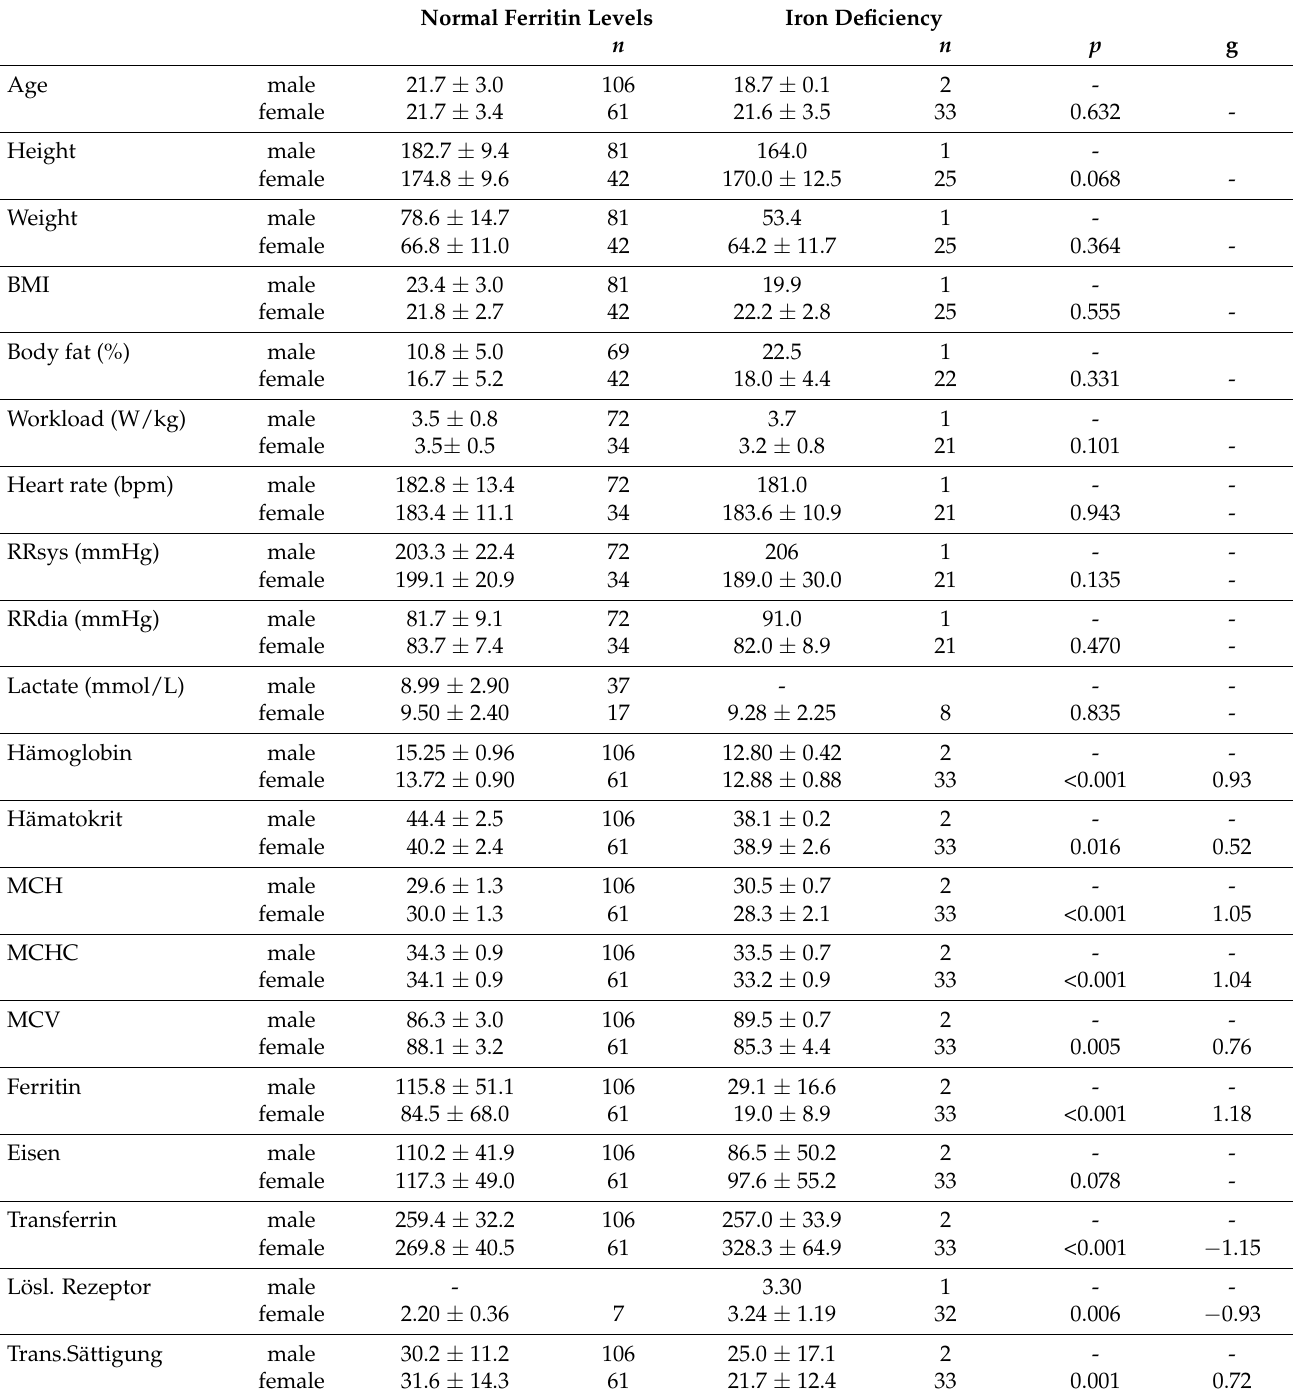
Table 4. Subject characteristics of adults (age ≥ 18